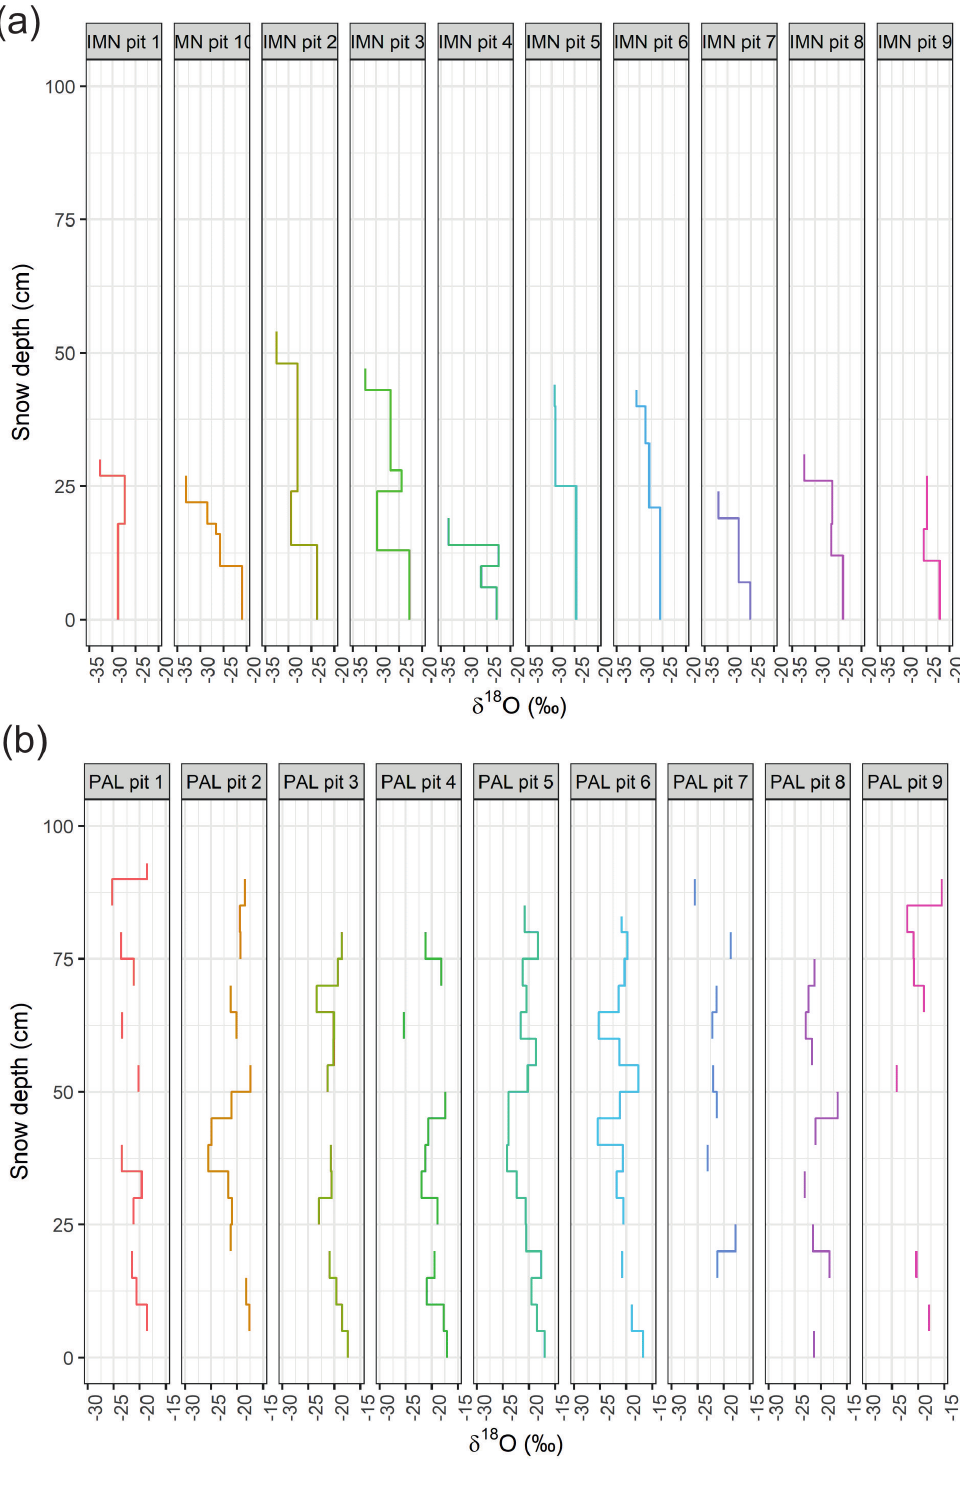
Figure 4. δ 18 O profiles for individual snowpits at ( a ) Imnavait and ( b ) Pallas. Zero on the y -axis represents the base of the